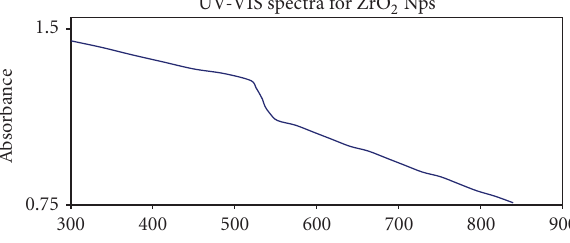
UV-VIS spectra for ZrO